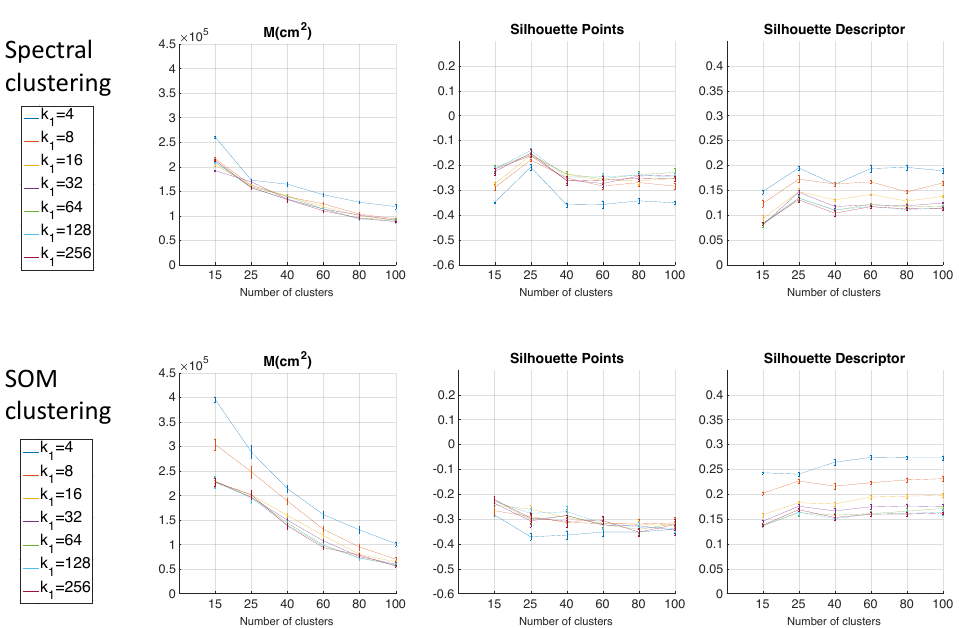
Figure 6. Results of the two clustering methods: average moment of inertia, average silhouette of points, and average silhouette of descriptors vs. number of clusters, when using FS in the Quorum V environment. SOM, Self-Organizing Maps.